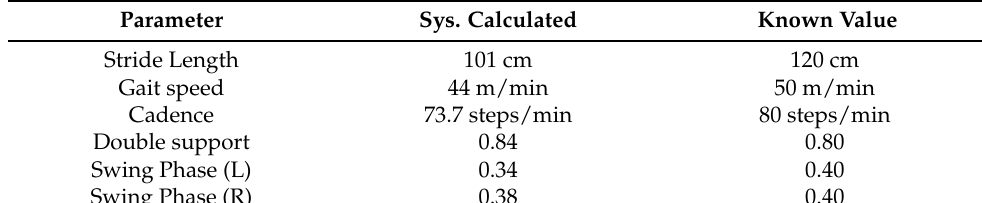
Table 1. The calculated gait parameter comparing with the known value.